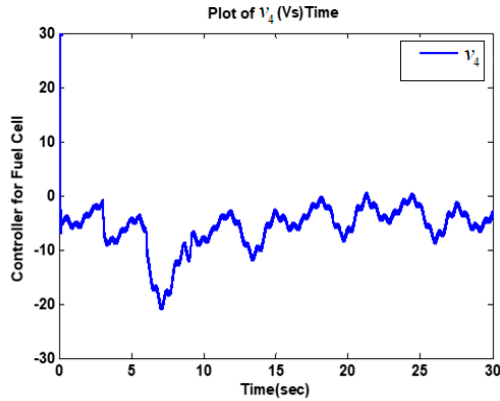
Figure 9. Time history of UC current command profile A .